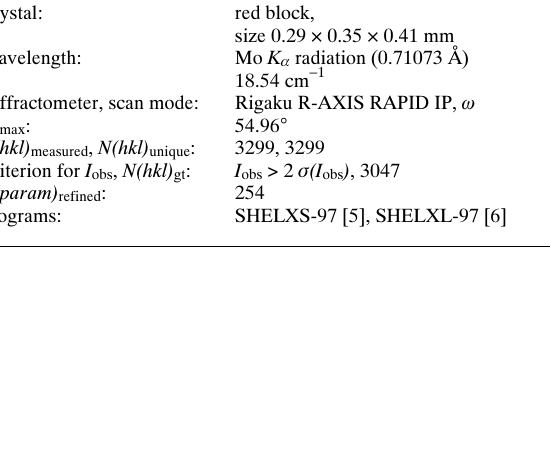
Table 3. Atomic coordinates and displacement parameters (in Å 2 ) . Atom Site Occ.